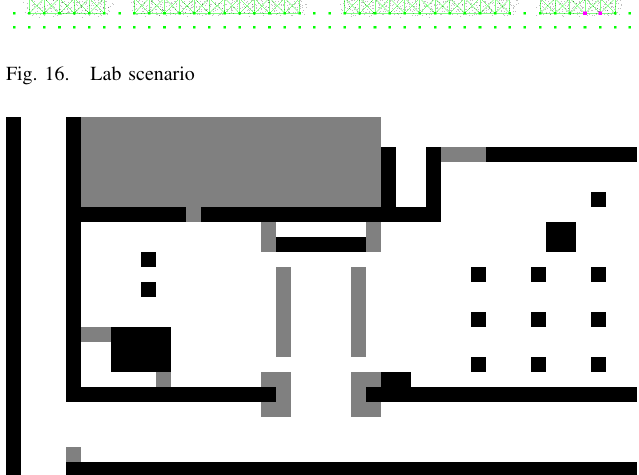
Fig. 17. Snack bar map input as image file